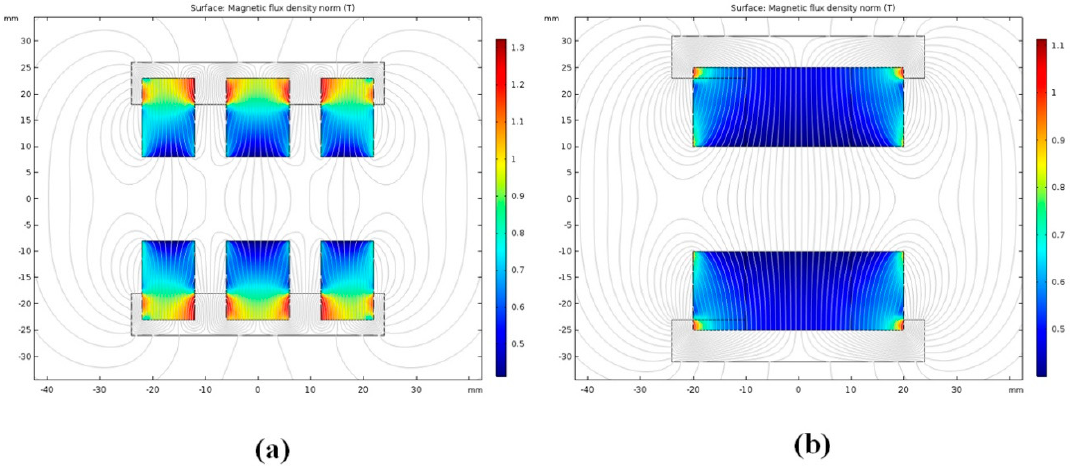
Figure 2. 2-D magnetism simulation results of the magnetic field induced as a function of the arrangement of permanent magnets obtained using COMSOL Multiphysics software. ( a ) Open-type and ( b )